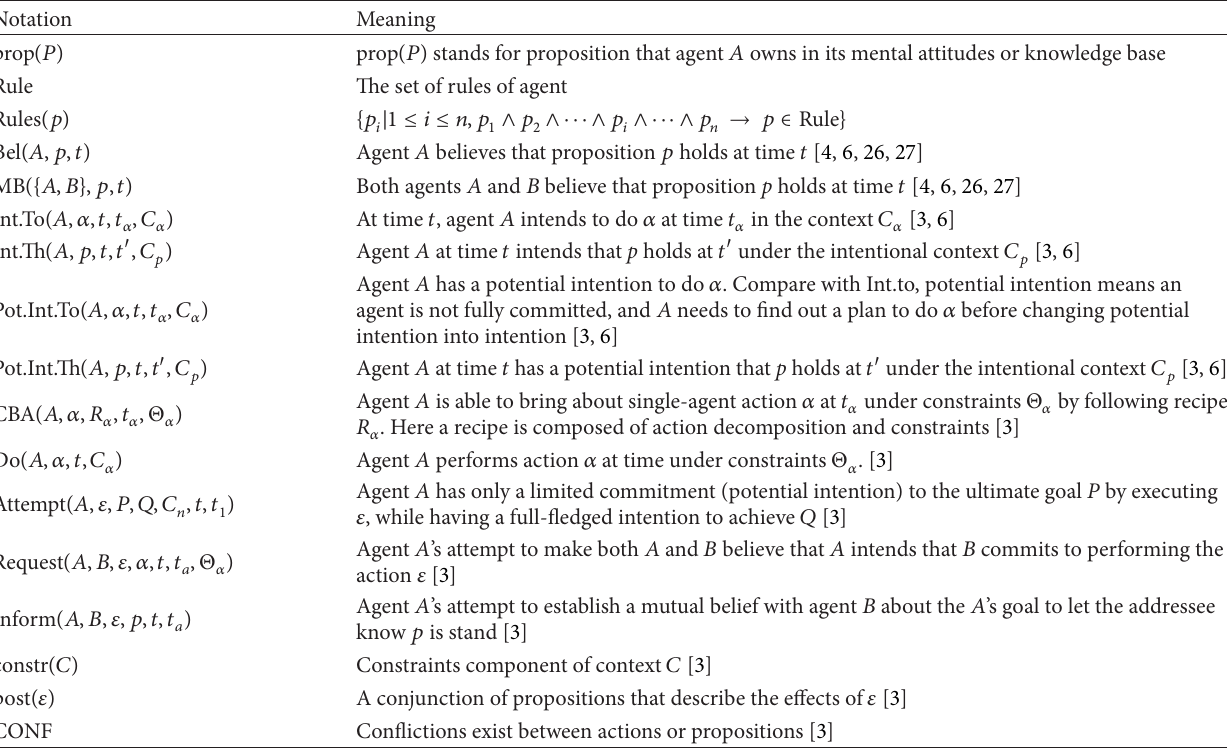
Table 1: Summary of